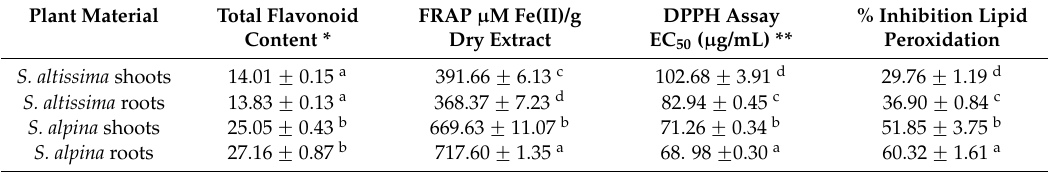
Table 1. Total phenolic compounds and antioxidant activities of S. altissima and S. alpina extracts determined by reducing power (FRAP), the DPPH scavenging assay and inhibition of linoleic acid peroxidation (TBARS detection).